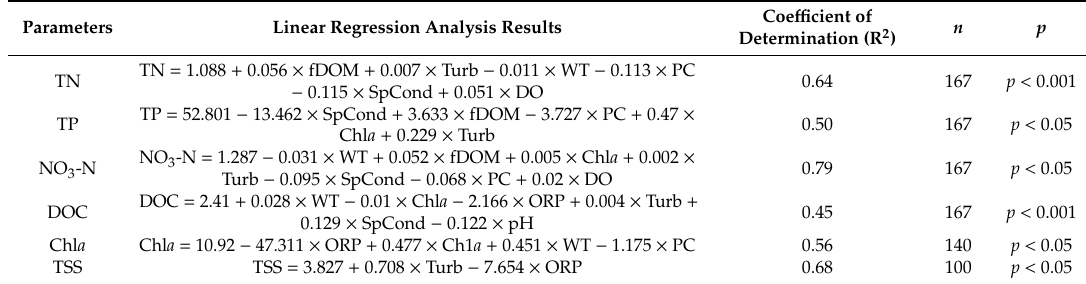
Table 3. Water quality parameter regression equations established by stepwise regression analysis